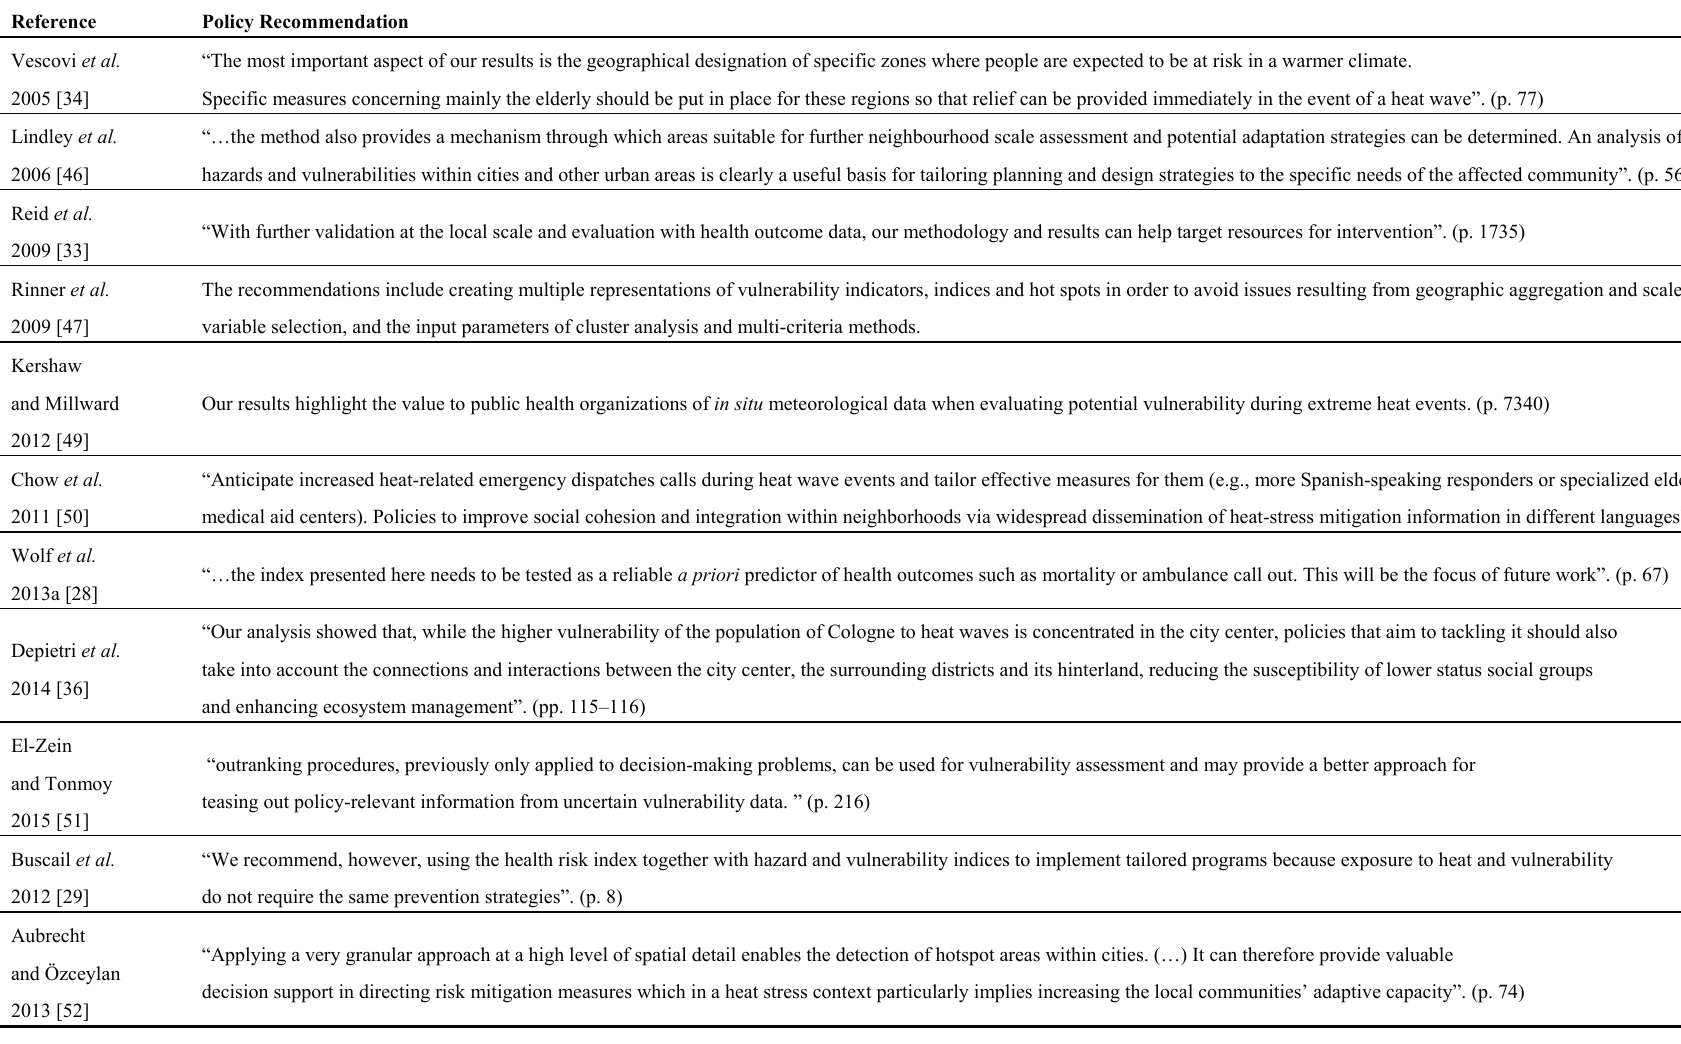
Table A1. Policy recommendation from “ a-priori ”/inductive heat vulnerability